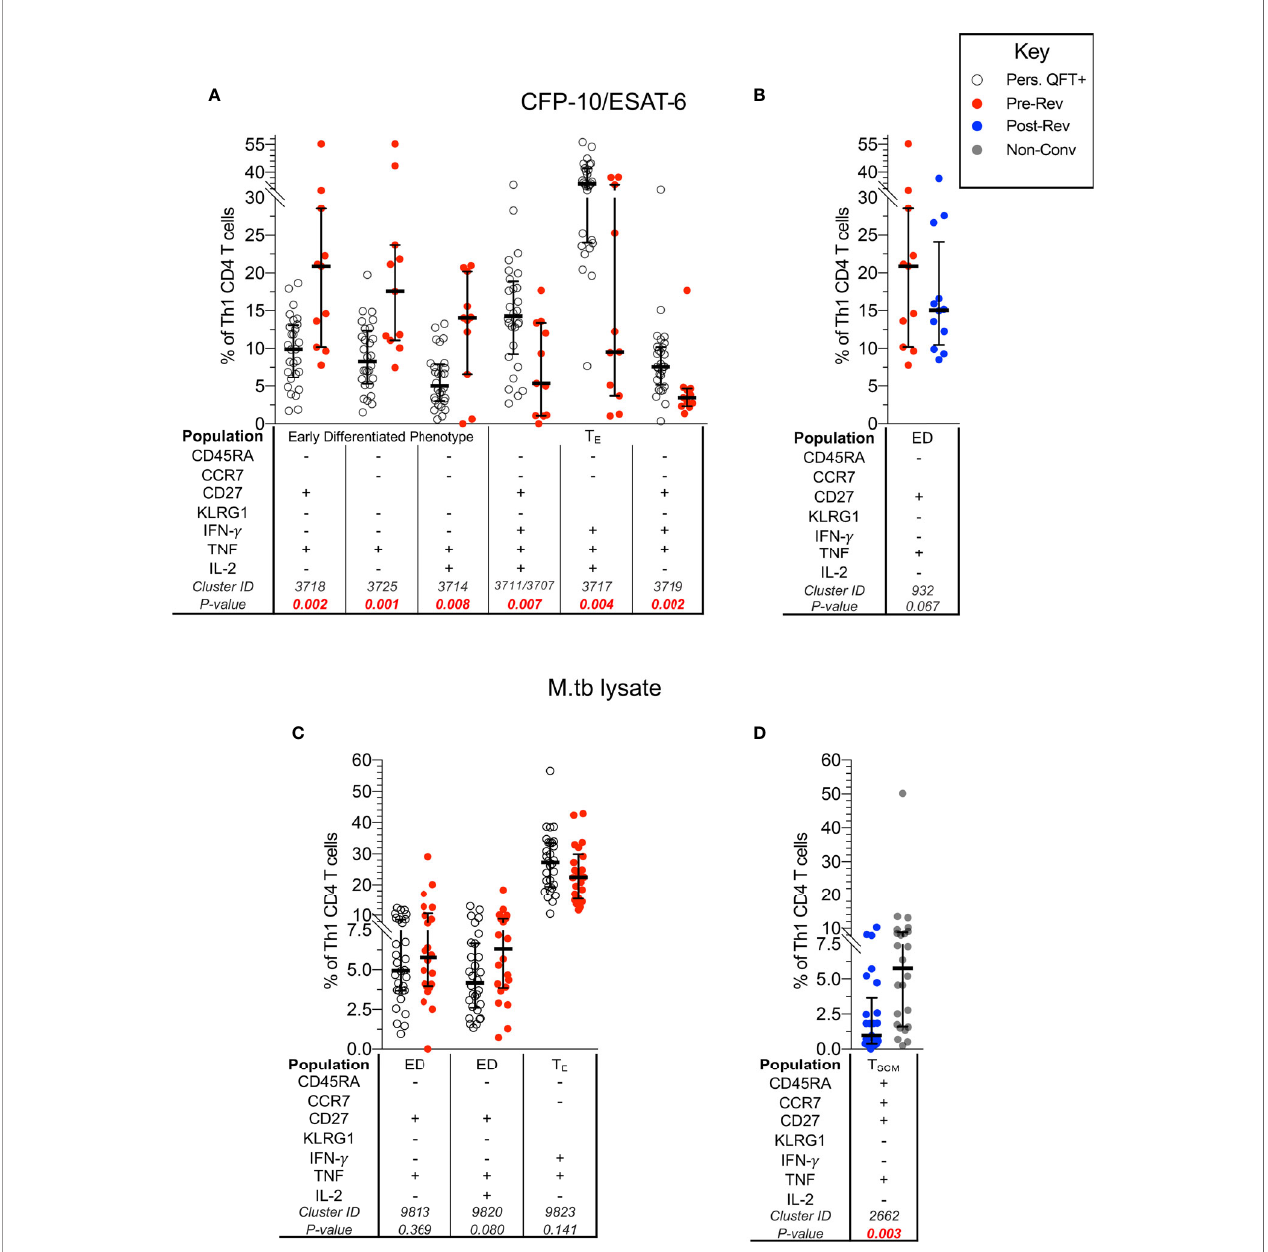
FIGURE 3 | CFP-10/ESAT-6-speci fi c memory/functional co-expression patterns are different between persistent QFT+ and reverters. Scatter plots (with medians and inter-quartile ranges) of manually gated memory and functional markers combinations representing CITRUS clusters that were different between: CFP-10/ESAT- 6-speci fi c CD4 T cells in (A) persistent QFT+ versus pre-reverters and (B) pre- versus post-reverters, and M.tb lysate-speci fi c CD4 T cells in (C) persistent QFT+ versus pre-reverters and (D) post-reverters versus non-converters. Number of participants, con fi rmatory statistical analysis and p-value calculations is as in Figure 2C